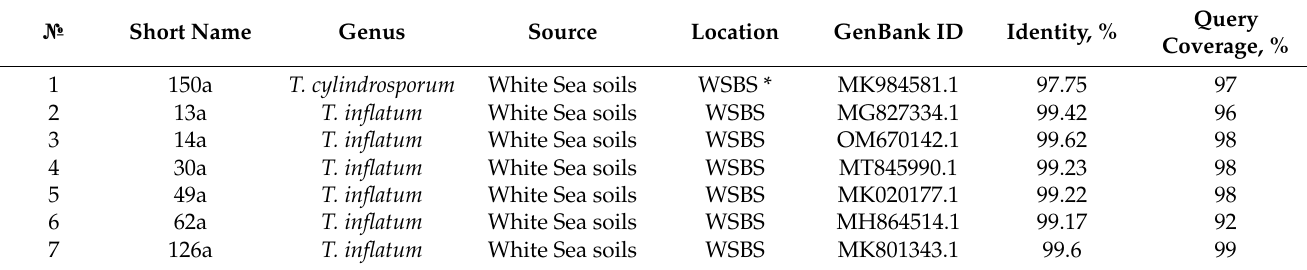
Table 1. Tolypocladium strains obtained from White-Sea-soil